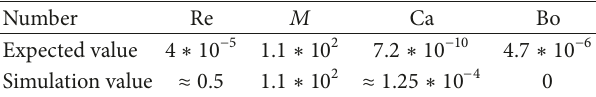
Table 4: Dimensionless numbers characterizing two-phase water- gas flow in clay